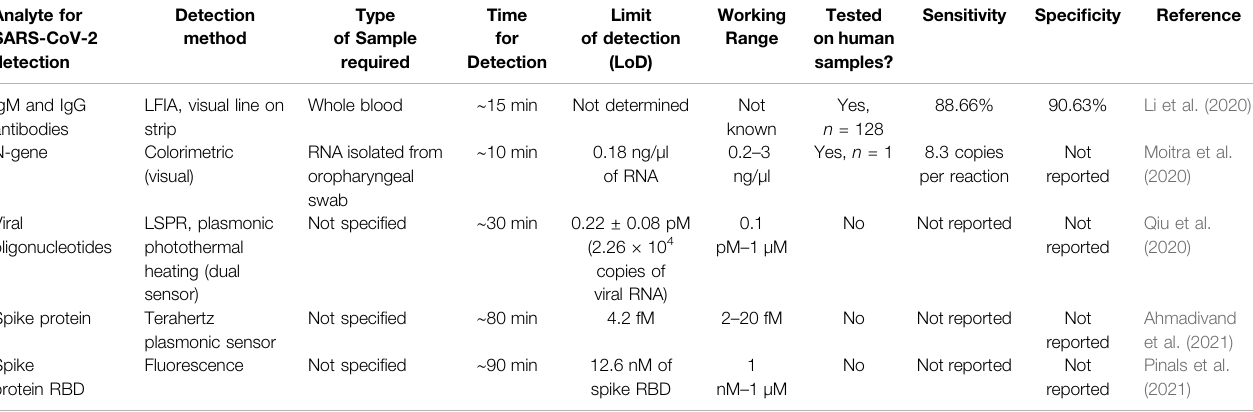
TABLE 2 | Summary of reported methods for detecting SARS-CoV-2 using optical biosensors based on carbon and plasmonic nanomaterials. Analyte for SARS-CoV-2